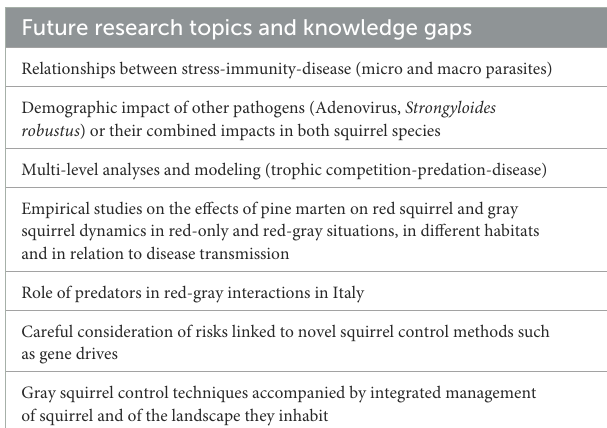
TABLE 3 Future research topics and knowledge